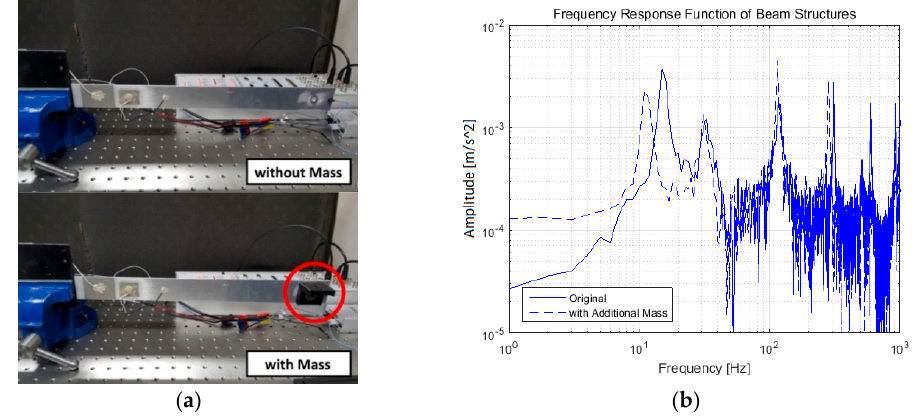
Figure 11. Frequency response function of beam structure: ( a ) two different configurations; and ( b ) comparison of frequency response function.